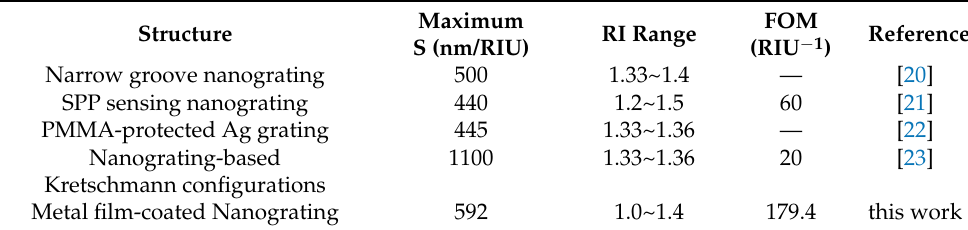
Table 1. Comparison of sensing capabilities with earlier reported works based on nanograting. Structure